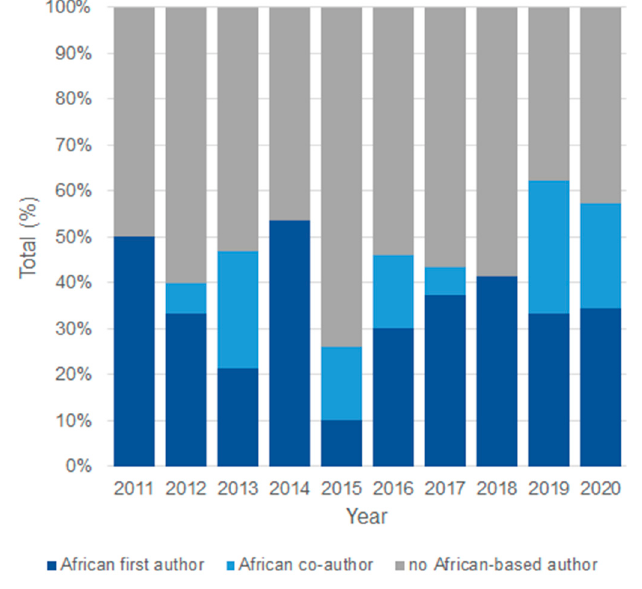
Figure 3. Author affiliations as noted from the survey, namely, articles which included African-based authors either as a first author or as a co-author and those published with no African-based affiliations.